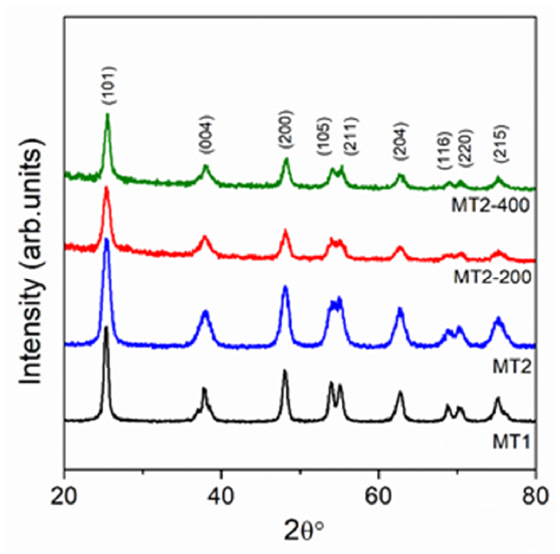
Figure 1. X-ray di ff raction (XRD) patterns of material (MT1) and all MT2 samples. Figure 1. X-ray diffraction (XRD) patterns of material (MT1) and all MT2 samples.